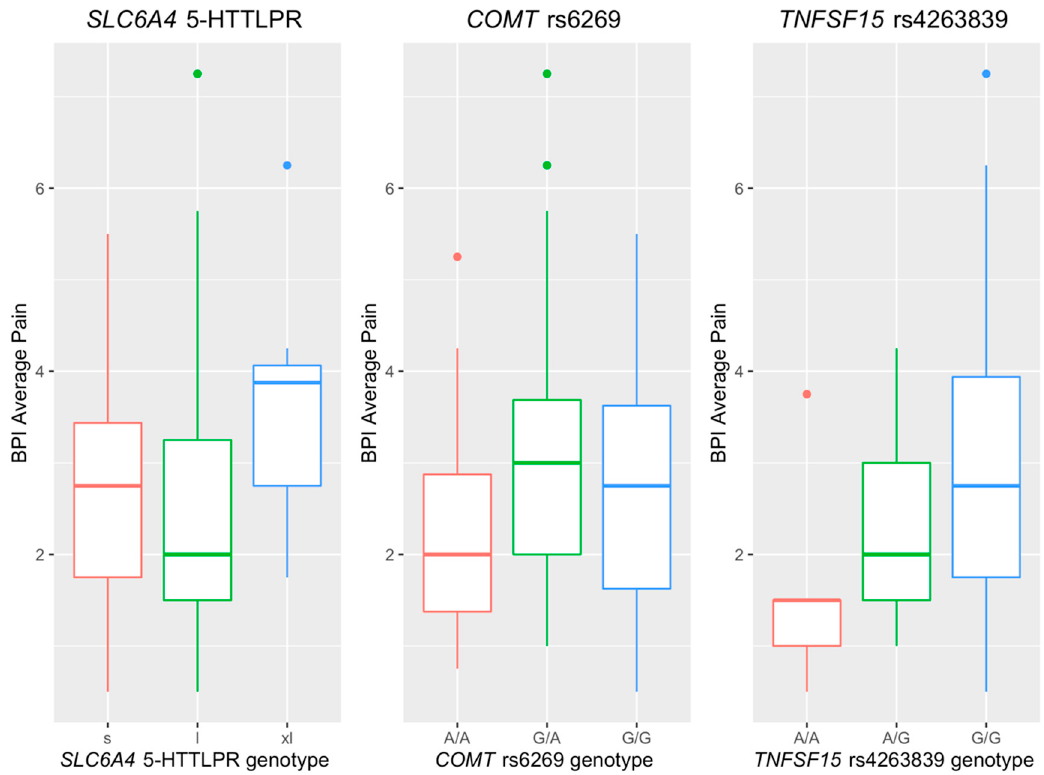
Figure 2. Boxplots for BPI average pain in the polymorphisms of SLC6A4 5-HTTLPR, COMT rs6269, and TNFSF rs4263839. Table 3. Results of linear regression models for pain and psychological symptom measurements vs. SNPs.